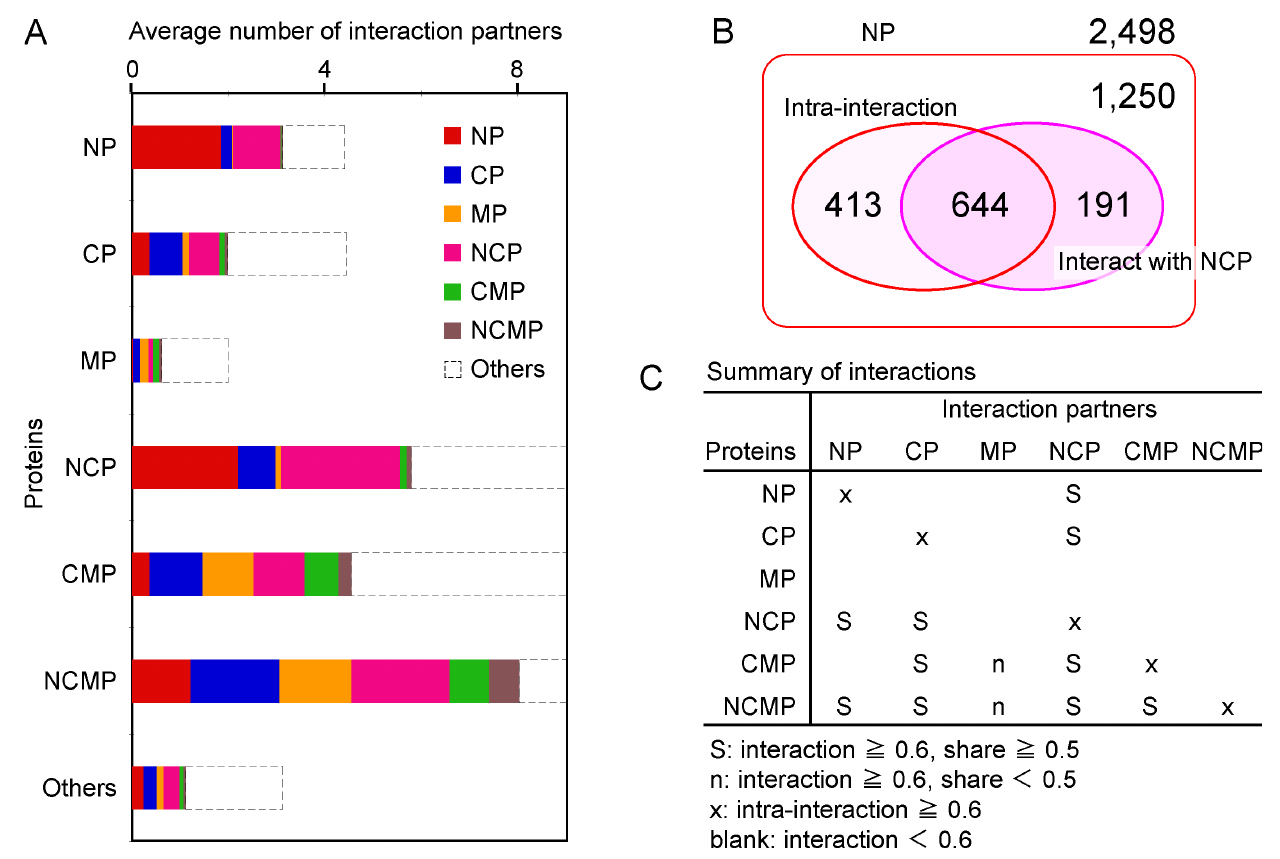
Fig 2. A. The average number of interactions decomposed by the interaction partners in 7 categories: NP, CP, MP, NCP, CMP, NCMP, and others. The full size view is shown in S2 Fig. B. The Venn diagram representing the interaction of NP with NCP. In total, 2,498 NP were analyzed. The NP with intra-interactions and interacting with NCP are shown by the two circles in the box. The intersection of two circles represents the shared interaction partners. Among these proteins, 1,250 NP neither intra-interact nor interact with NCP. C. The summary of interactions in terms of interaction partners. S symbols indicate that the interaction is rich (at least 0.6 interaction partners) between the protein (the left column) and the interaction partners (the top row), and the interaction partners are shared (at least 0.5) with the intra-interactions of partner proteins (S6 Table). For other symbols, see the bottom of the